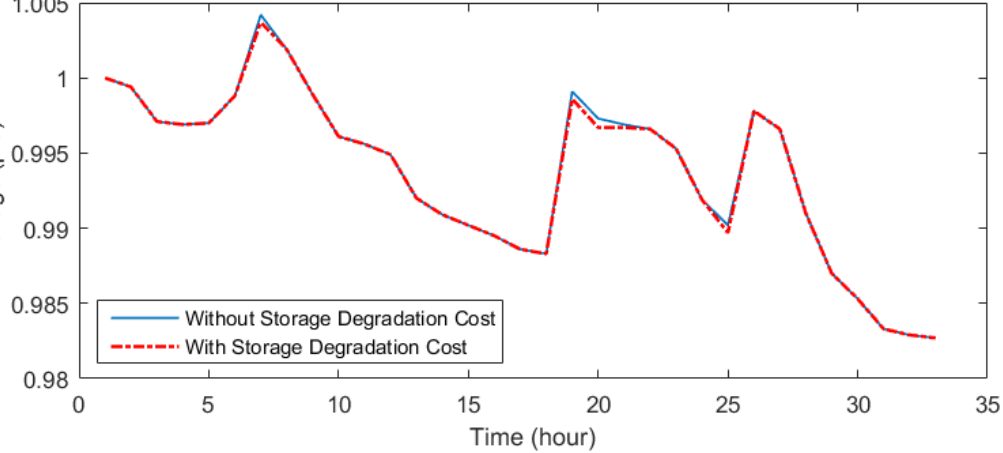
Figure 15. Voltage profile of the network by considering/neglecting the BDC in WT/Battery sched-